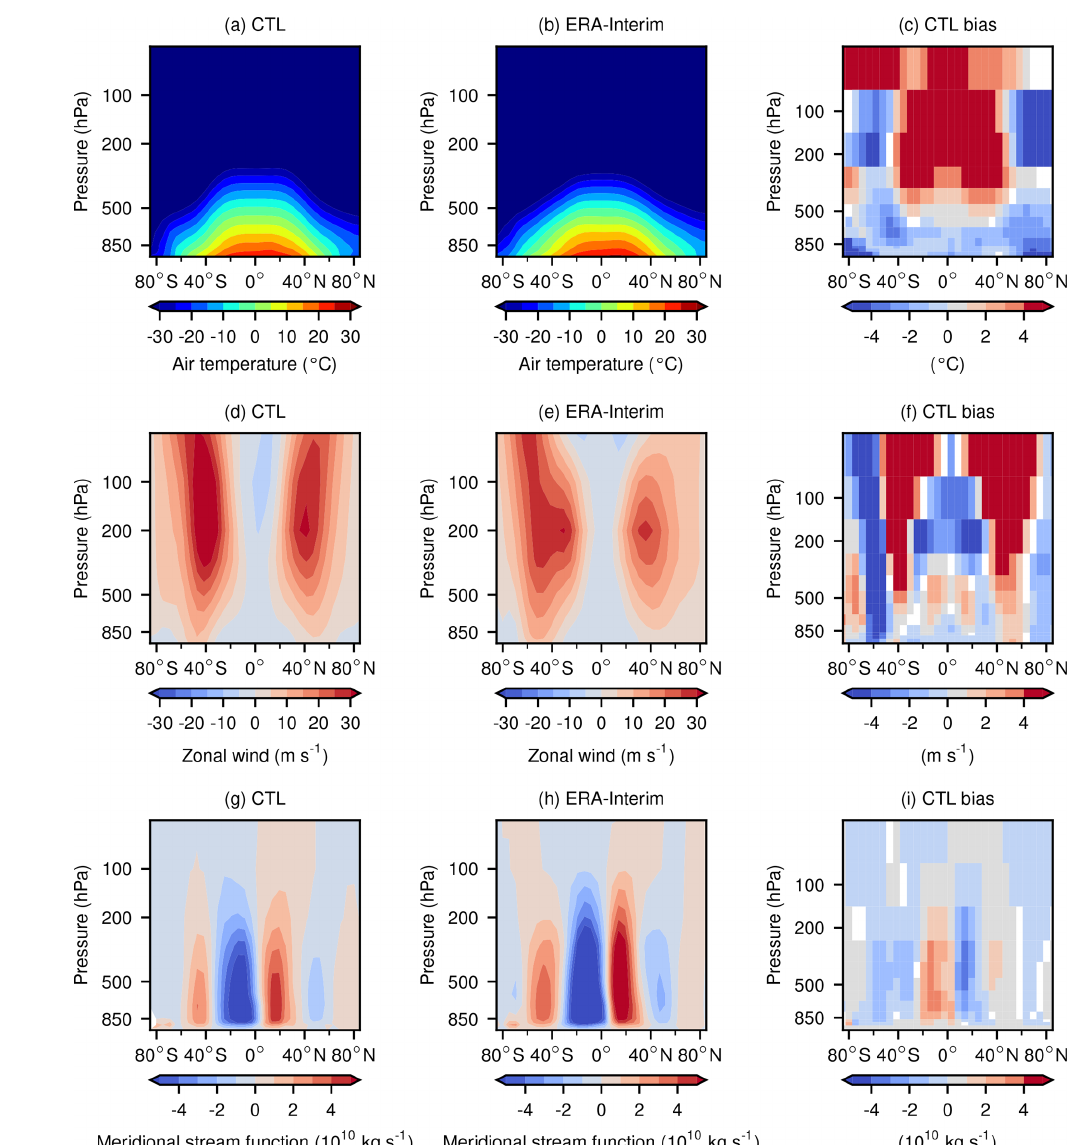
Figure 4. Zonal average annual means results for the CTL simulation compared with ERA-Interim at different pressure levels for air temperature in CTL (a) , ERA-Interim (b) , and model bias (c) ; zonal wind in CTL (d) , ERA-Interim (e) , and model bias (f) ; and meridional mass stream function in CTL (g) , ERA-Interim (h) , and model bias (i) . In the bias panels, white depicts grid points with statistically non- significant difference ( α = 0 .